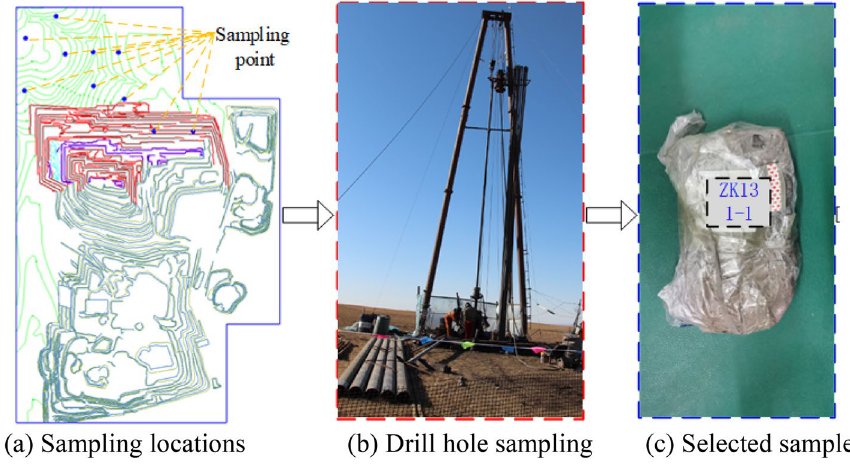
Figure 1. Standard rock sample preparation